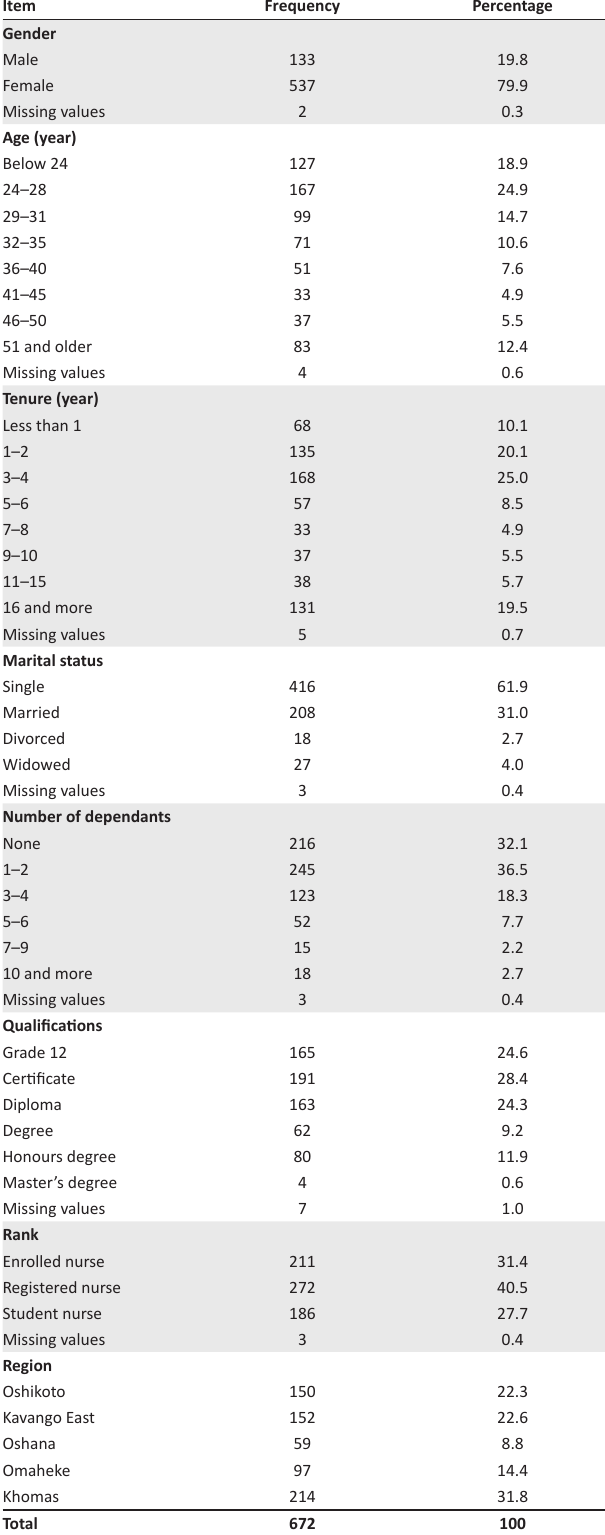
TABLE 1: Frequency distribution of the sample ( n =